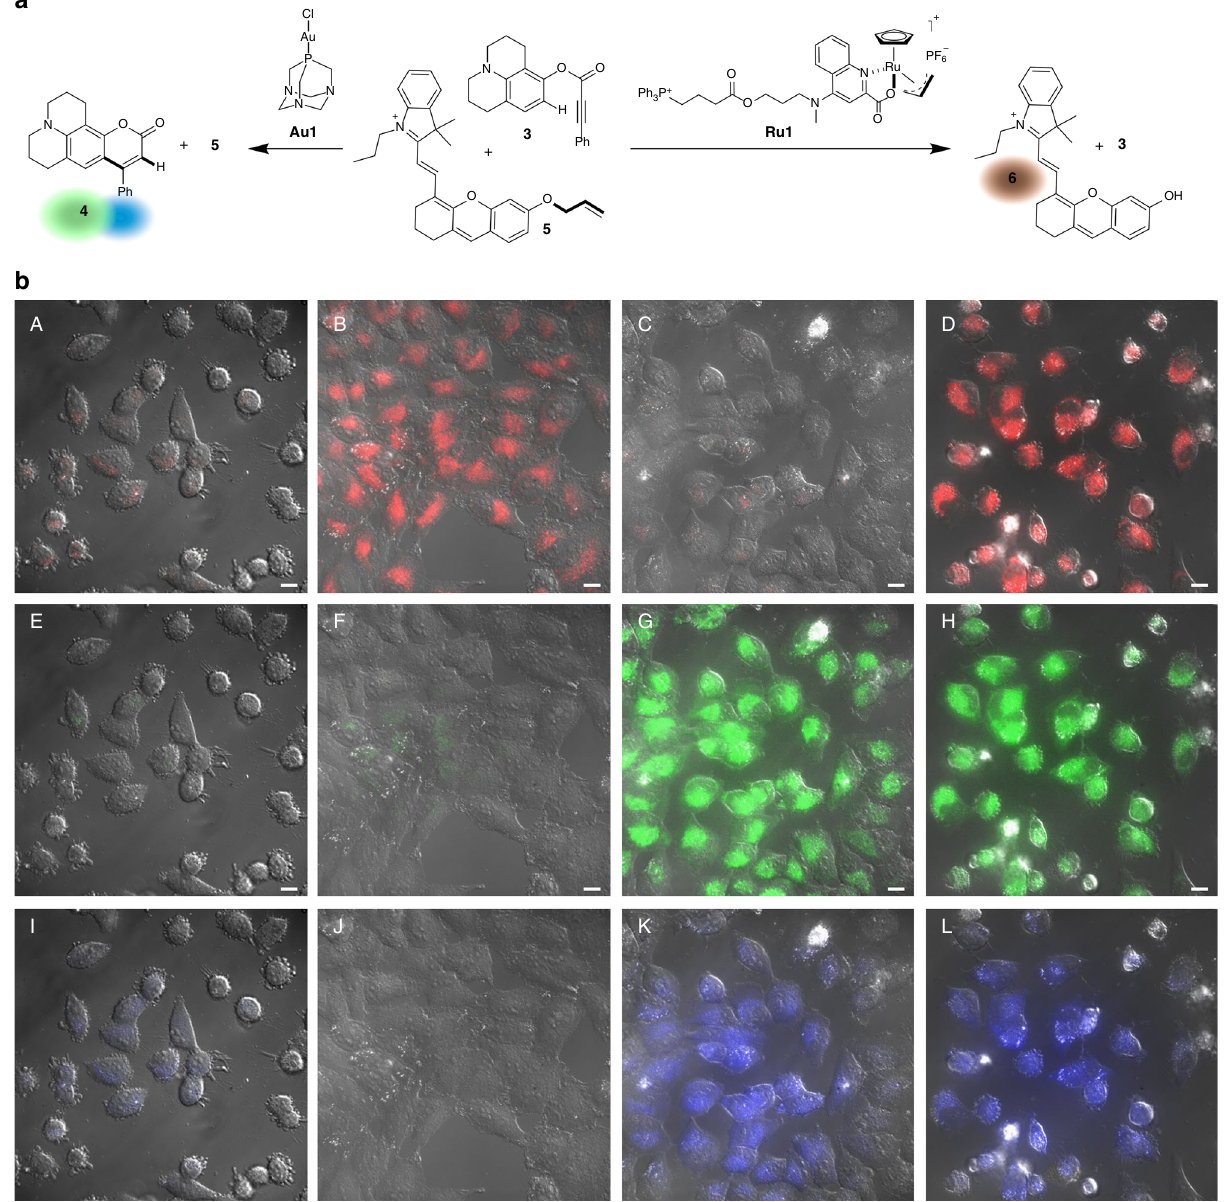
Fig. 5 Concurrent Au(I) and Ru(II) catalysis inside HeLa cells. a Schematic representation of the ruthenium and the gold-mediated reactions. b Intracellular transformations. A, E, I) Red, green, and blue fl uorescence of the substrates 3 and 5 in cells; (B, F, J) Red, green, and blue fl uorescence of cells incubated with Ru1 followed by addition of substrate 5 and 3 ; (C,G,K) Red, green, and blue fl uorescence of cells incubated with Au1 followed by addition of substrate 3 and 5 ; (D, H, L) Red, green, and blue fl uorescence of cells incubated with Ru1 and Au1 followed by addition of substrates 3 and 5 . Reaction conditions: Cells were incubated with Ru1 (25 µ M) and/or Au1 (50 µ M) for 30 min, followed by two washings with DMEM and treatment with substrate 3 (50 µ M) and/or 5 (100 µ M), respectively, for 6 h. Scale bar: 12.5 µ